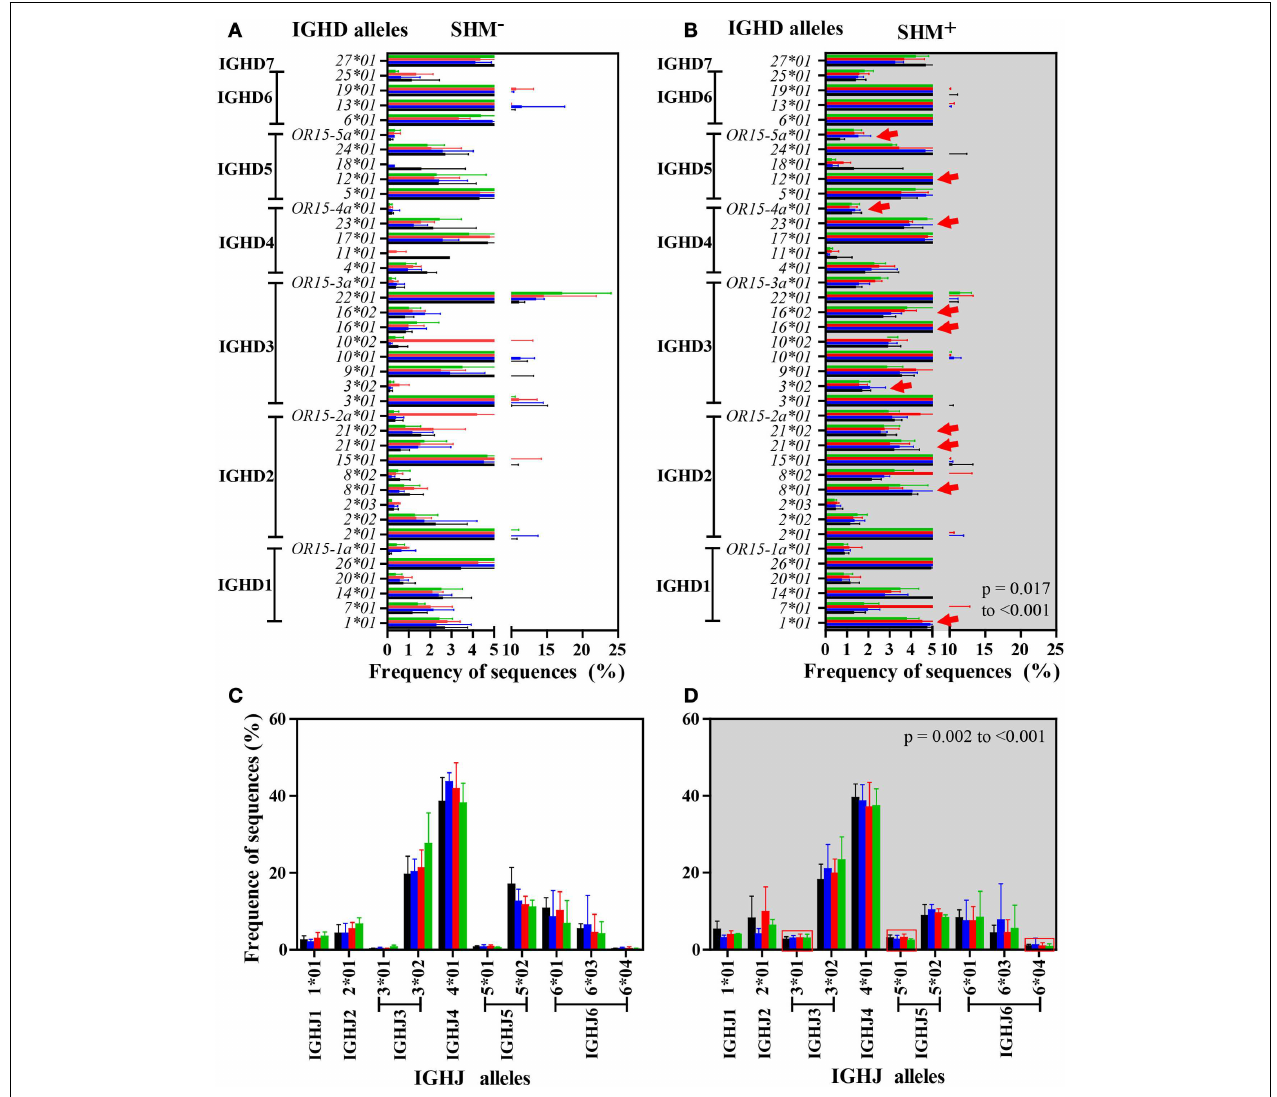
IGHD3-3*02, IGHD3-16*01, IGHD3-16*02, IGHD4-23*01, IGHD4/OR15-4a*01, IGHD5-12*01, and IGHD5/OR15-5a*01 (red arrows), and 3 IGHJ alleles, including IGHJ3*01, IGHJ5*01, and IGHJ6*04 (squared by red), was observed across the groups in SHM + sequences in comparison to SHM − sequences ( p < 0.001 respectively). Bars (mean/SD): HC, black; SLE, blue; HIV-infected individuals: untreated, red; treated,